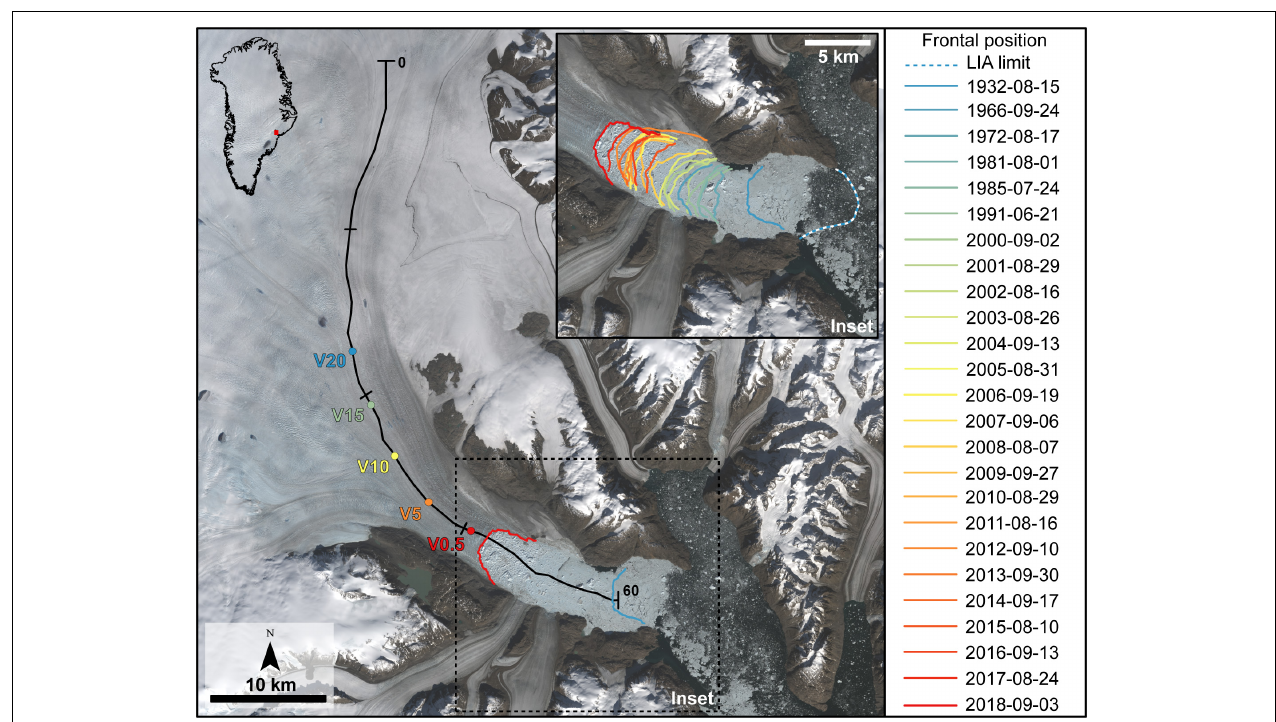
FIGURE 1 | Overview of Kangerlussuaq Glacier and mapped historical terminus positions (inset). Black line indicates the center line profile plotted in Figures 4 , 7 . Points V0.5 – V20 mark the locations for the velocity series shown in Figure 3B and indicate the distance (in km) from the most retreated ice front (16 May 2018). Annual ice fronts between 2013 and 2018 are from this study and ice fronts prior to 2013, including the Little Ice Age limit, are from Khan et al. (2014). Background image is Landsat 8 scene from 03 September 2018 (path 231 and row